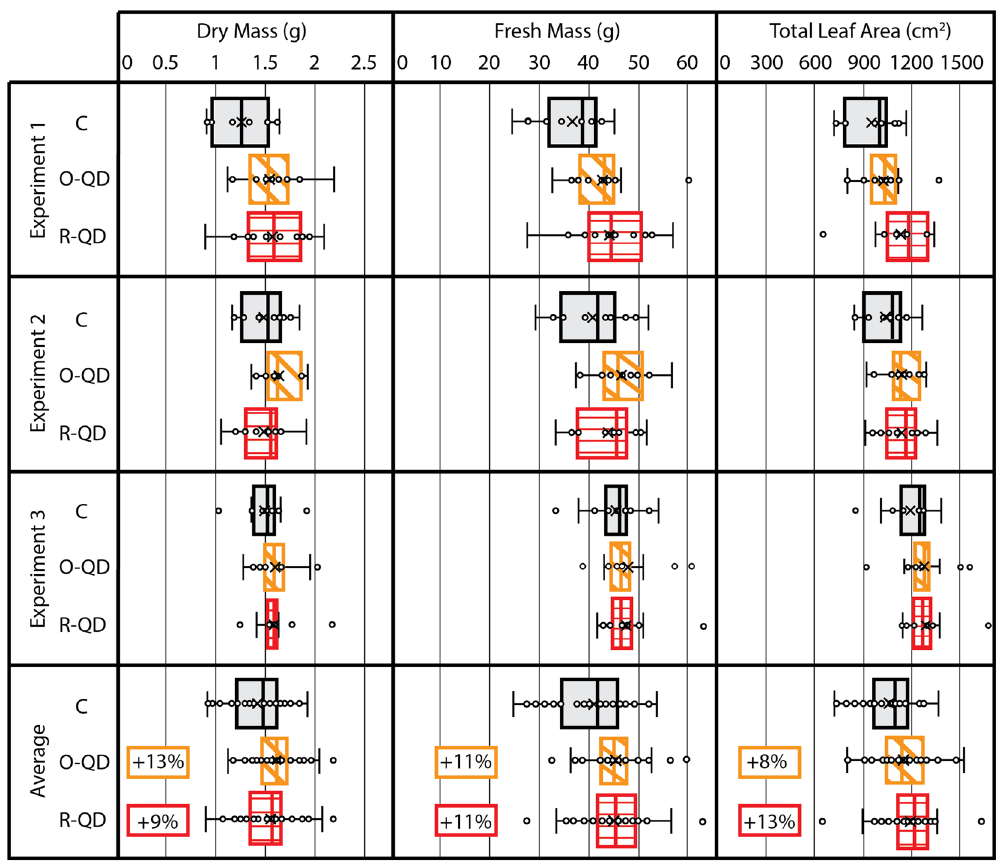
Fig. 3 Experimental results of lettuce plant trials. Experimental results of measured edible dry mass, edible fresh mass, and total leaf area for three replicate lettuce experiments under three different light spectra ( n = 12 per group in each treatment; N = 36 per experiment). Error bars show one standard deviation. Cohen ’ s d effect sizes for each metric were statistically signi fi cant with a con fi dence level of 95%.